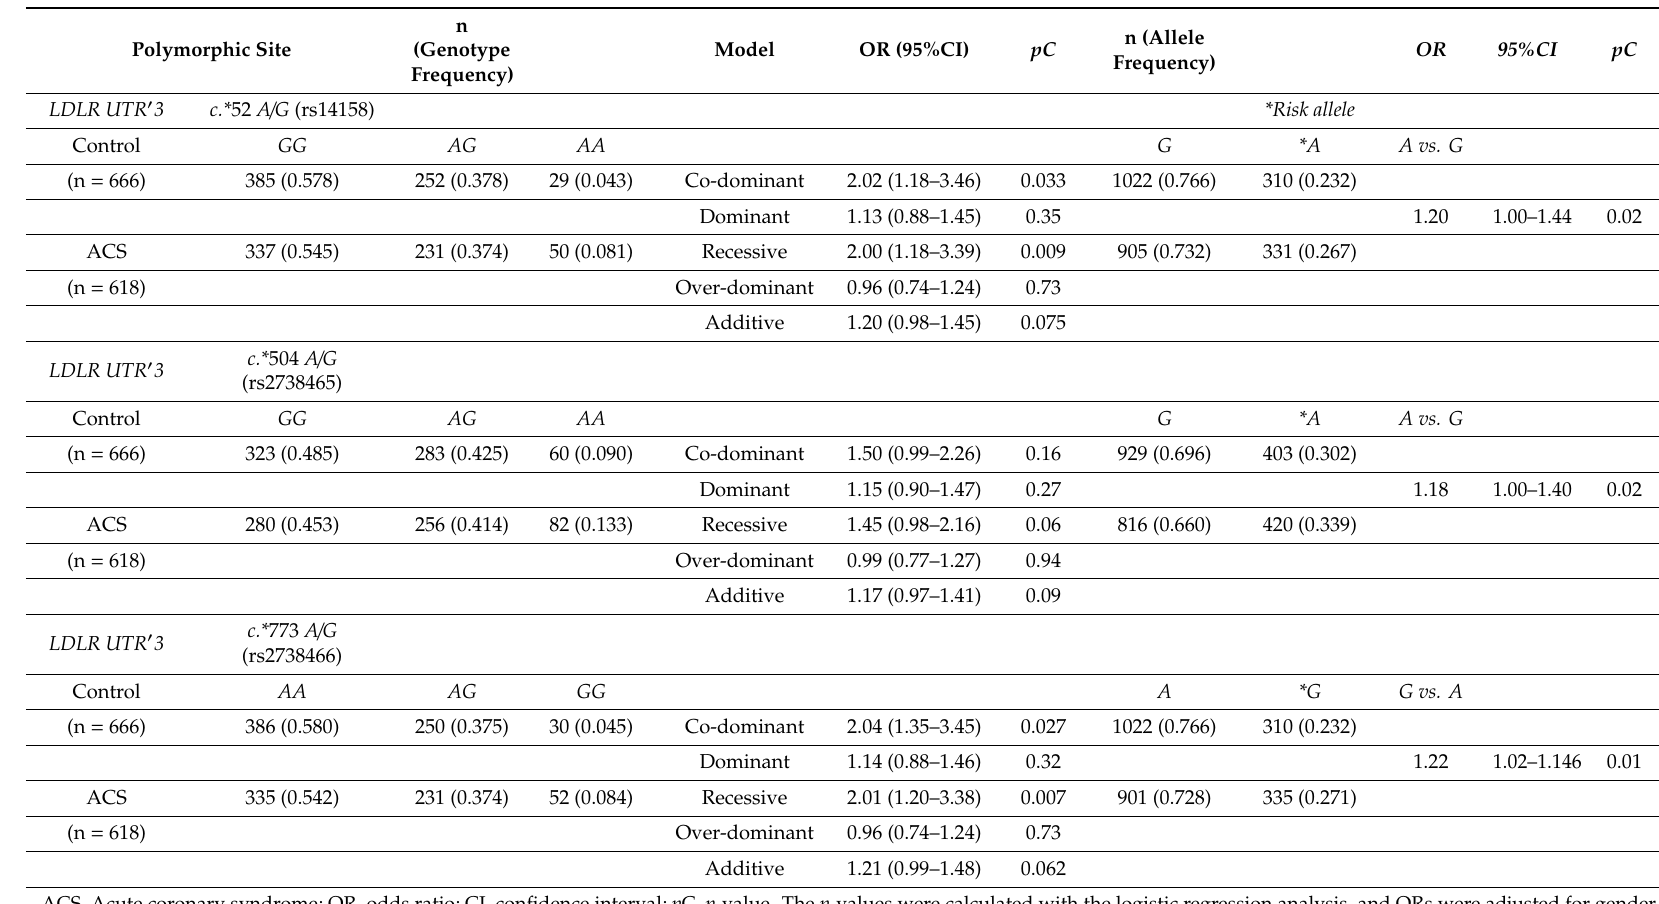
Table 2. Distribution of LDLR polymorphisms in ACS patients and healthy